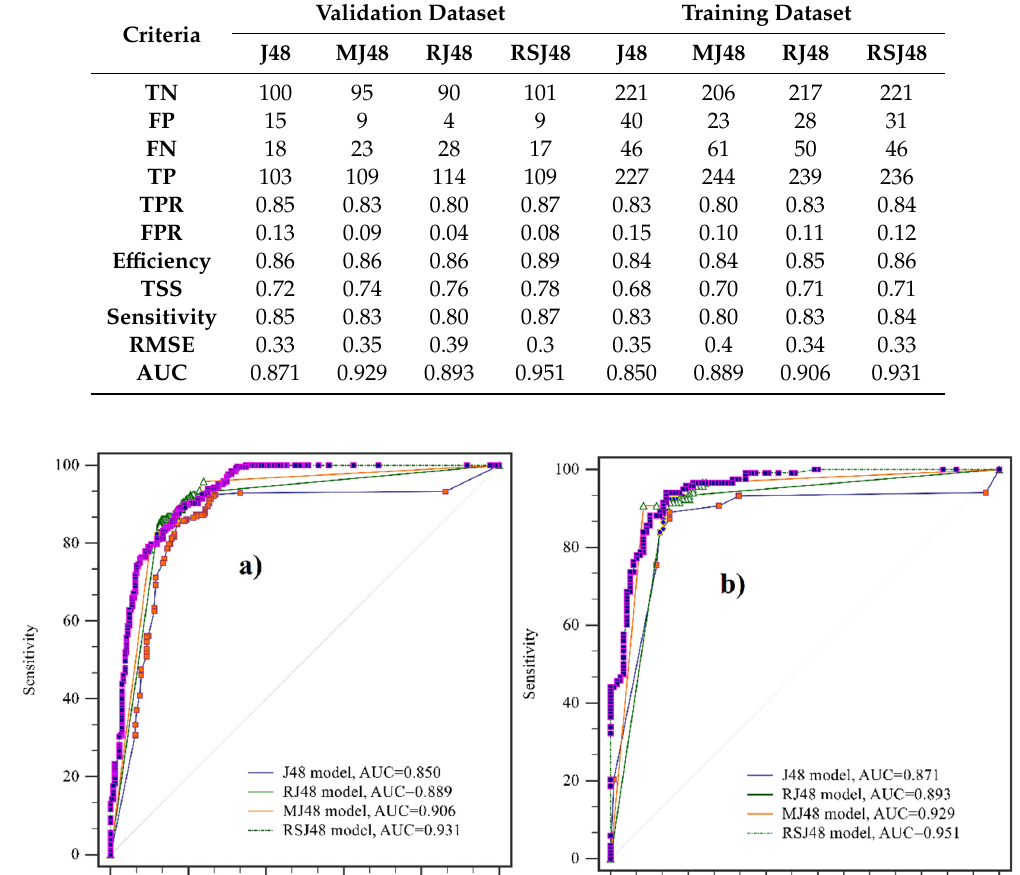
Figure 8. Trend of the frequency ratio (FR) in different models. 3.5. Sensitivity Analysis A sensitivity research was conducted to determine the FCF’s impact on the estimation of flood susceptibility. The results were summarized as percentage contribution (PC; Table 5 and Figure 9). Flood susceptibility maps produced by the ensemble ML method had the greatest sensitivity to elevation, followed by distance to the stream, NDVI, slope, LU/LC, rainfall, TWI, SPI, drainage density TPI, lithology, convergence index and soil type (Figure 9). Study of sensitivity may help in understanding the significant geo-environmental factor, which are very relevant for understanding the model structure in question. According to the sensitivity evaluation, in the case of RSJ48, every factor had a greater percentage contribution compared to the other ML models. Therefore, based on the analysis, it can be said that RSJ48 is better than the other models we tested.